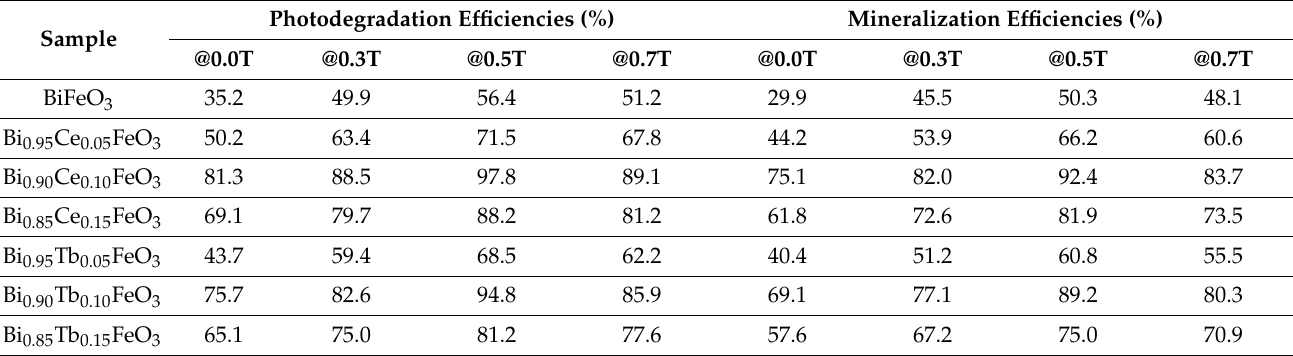
Table 1. Photodegradation and Mineralization efficiencies of PR over BFO: RE nanostructures at different magnetic fields.